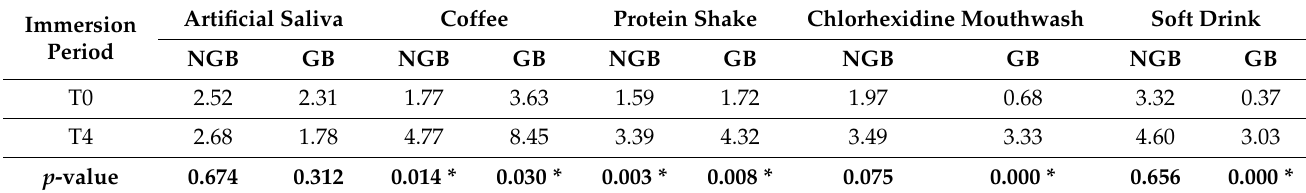
Table 4. Comparison of ∆ E between T0 and T4 for the multilayer zirconia group.